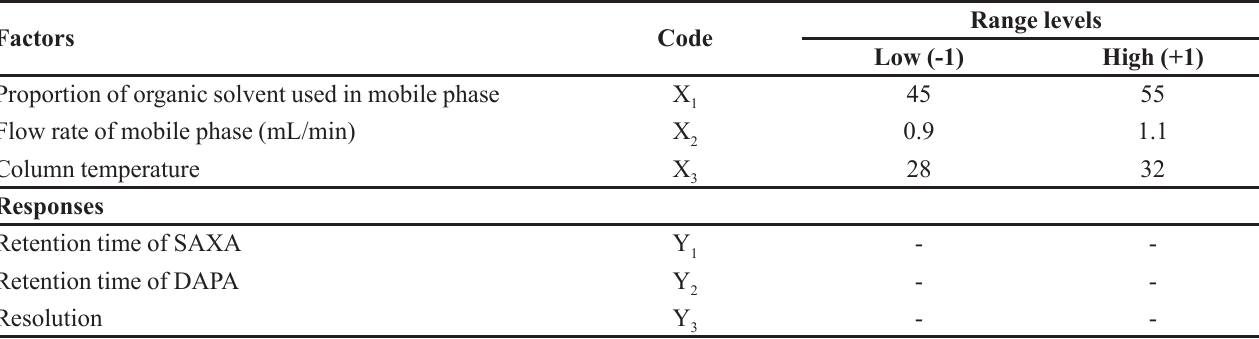
TABLE I - Experimental plan of CCD showing factors with levels Factors Proportion of organic solvent used in mobile phase